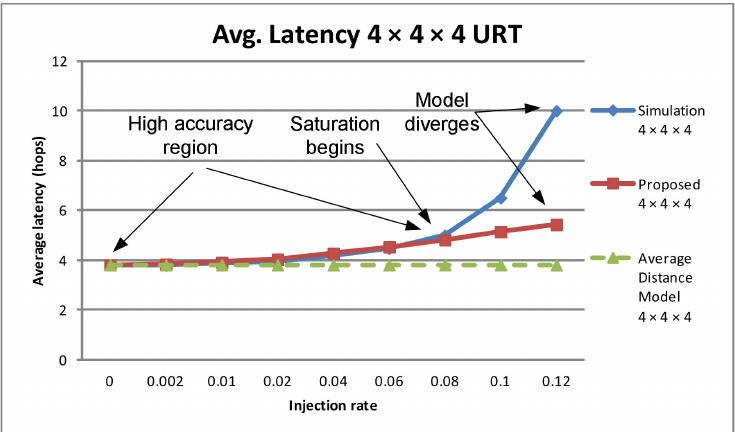
Figure 5. Average estimated latency vs. flit injection rate comparison between simulation, the proposed model and the average distance model for a 4 × 4 × 4 NoC topology and uniform ran- dom traffic. The high-accuracy region, the beginning of saturation and the model divergence are clearly marked.